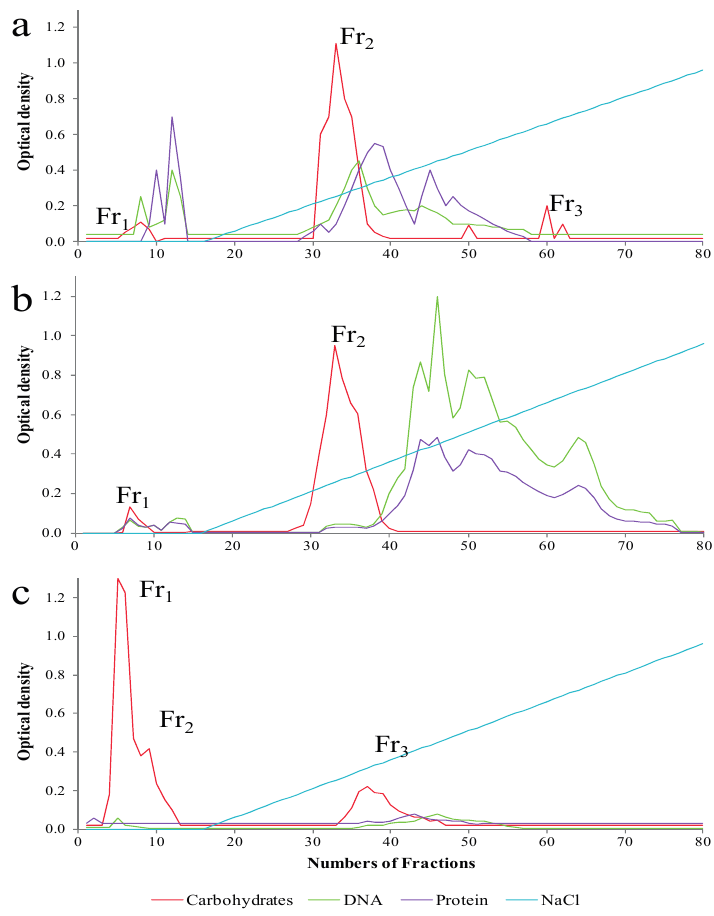
Figure 2. Elution profiles from DEAE-Sepharose CL-6B of EPSs fractions produced by Bacillus licheniformis strain B3-15 ( a ); Geobacillus thermodenitrificans strain B3-72 ( b ); Bacillus licheniformis strain T14 ( c